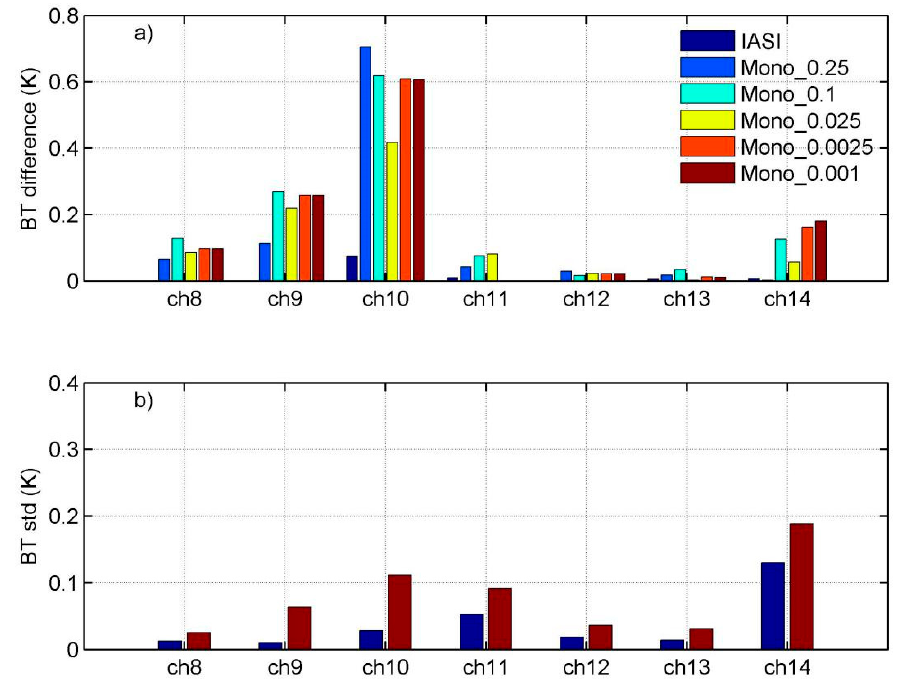
Figure 4. ( a ) Mean values of absolute BTDs between the two interpolation schemes calculated from the six standard atmospheric profiles with respect to six different hyperspectral IR radiance spectra (apodized IASI spectra of 0.25 cm − 1 , monochrome spectra of 0.25 cm − 1 , 0.1 cm − 1 , 0.025 cm − 1 , 0.0025 cm − 1 , and 0.001 cm − 1 ) for seven AGRI IR bands. ( b ) STDs from convoluted BTs calculated from the six standard atmospheric profiles with respect to three types of IR spectra, using two different interpolation schemes.